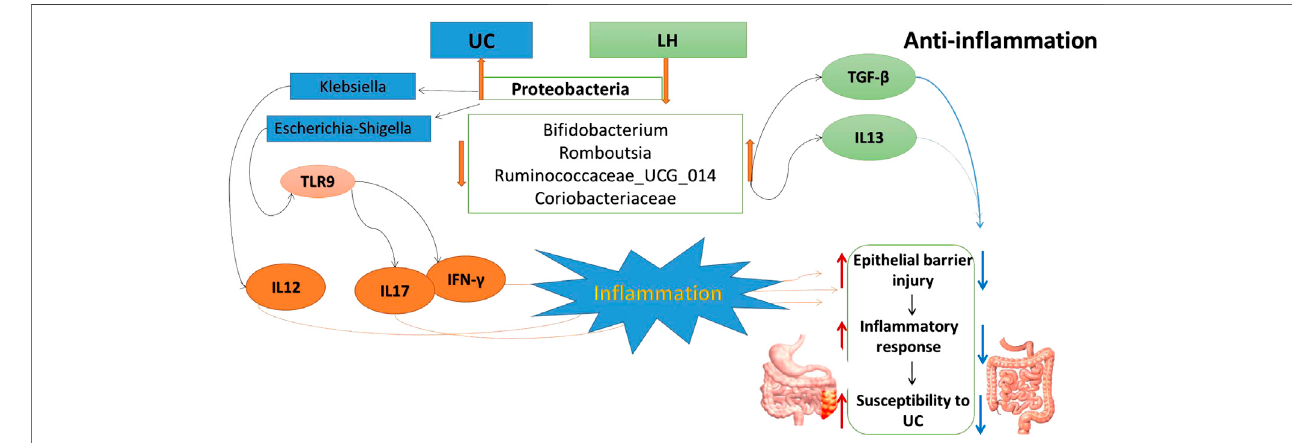
FIGURE 12 | Possible partial mechanisms of UC pathogenesis and LH treatment for